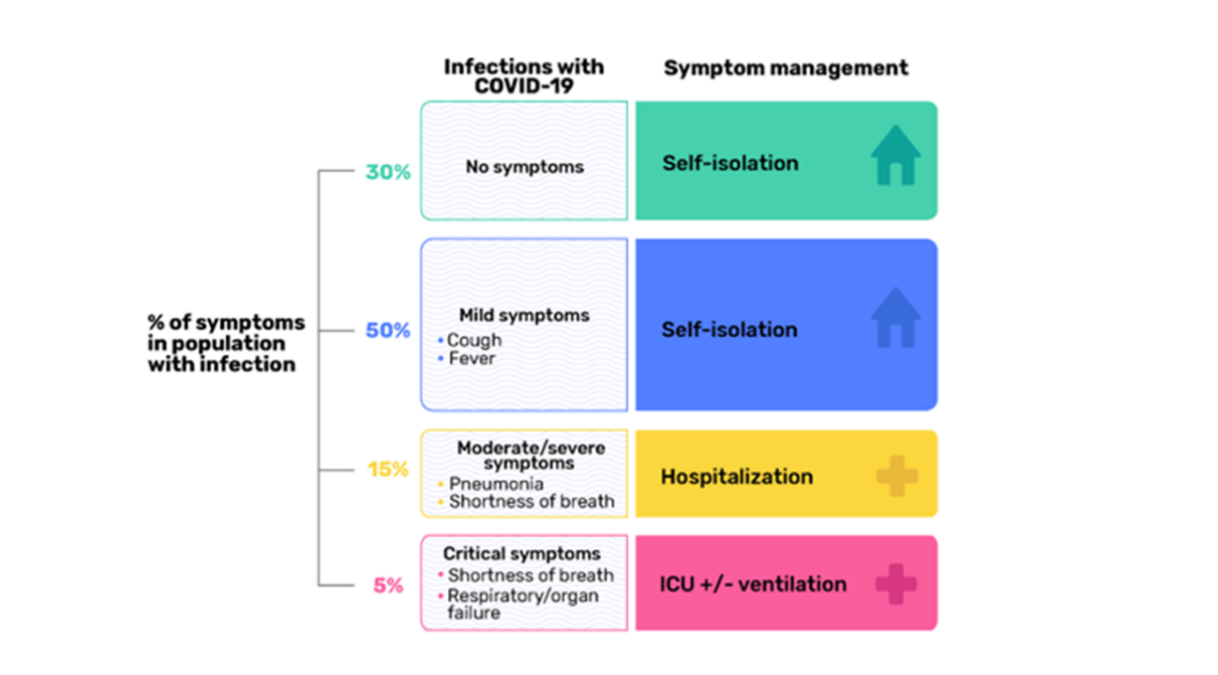
Figure 1. The burden of COVID-19 morbidity and